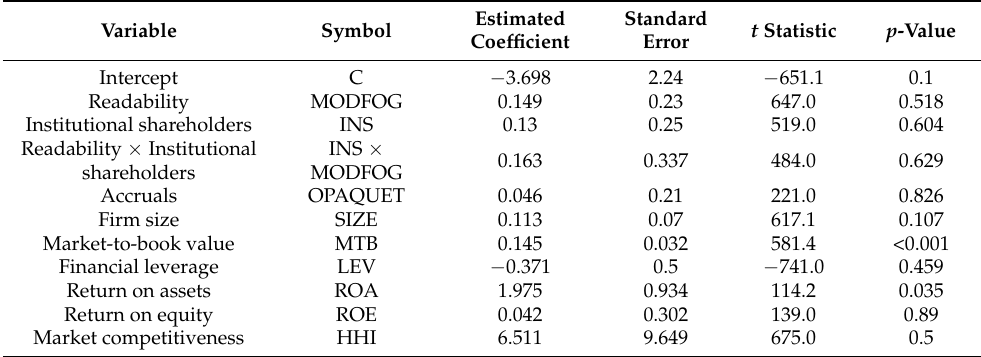
Table 11. Sensitivity analysis of the second hypothesis.